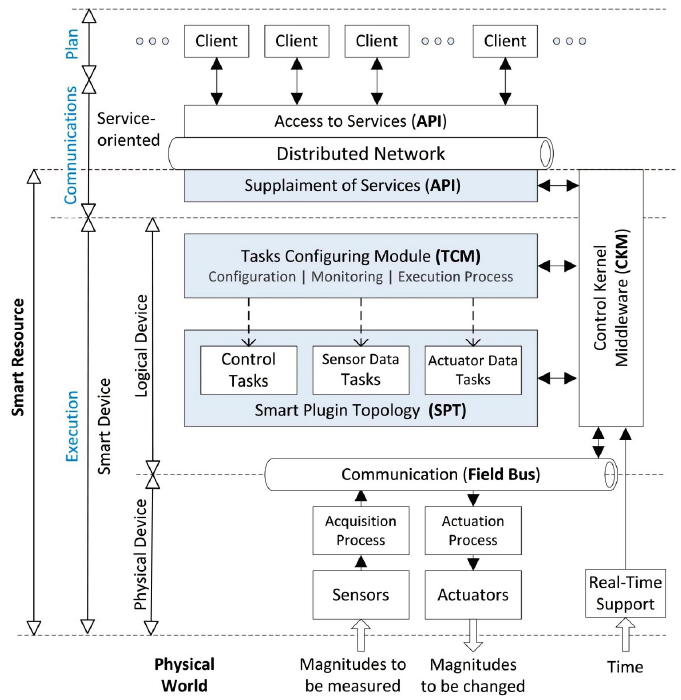
Figure 2. Smart resource: components and